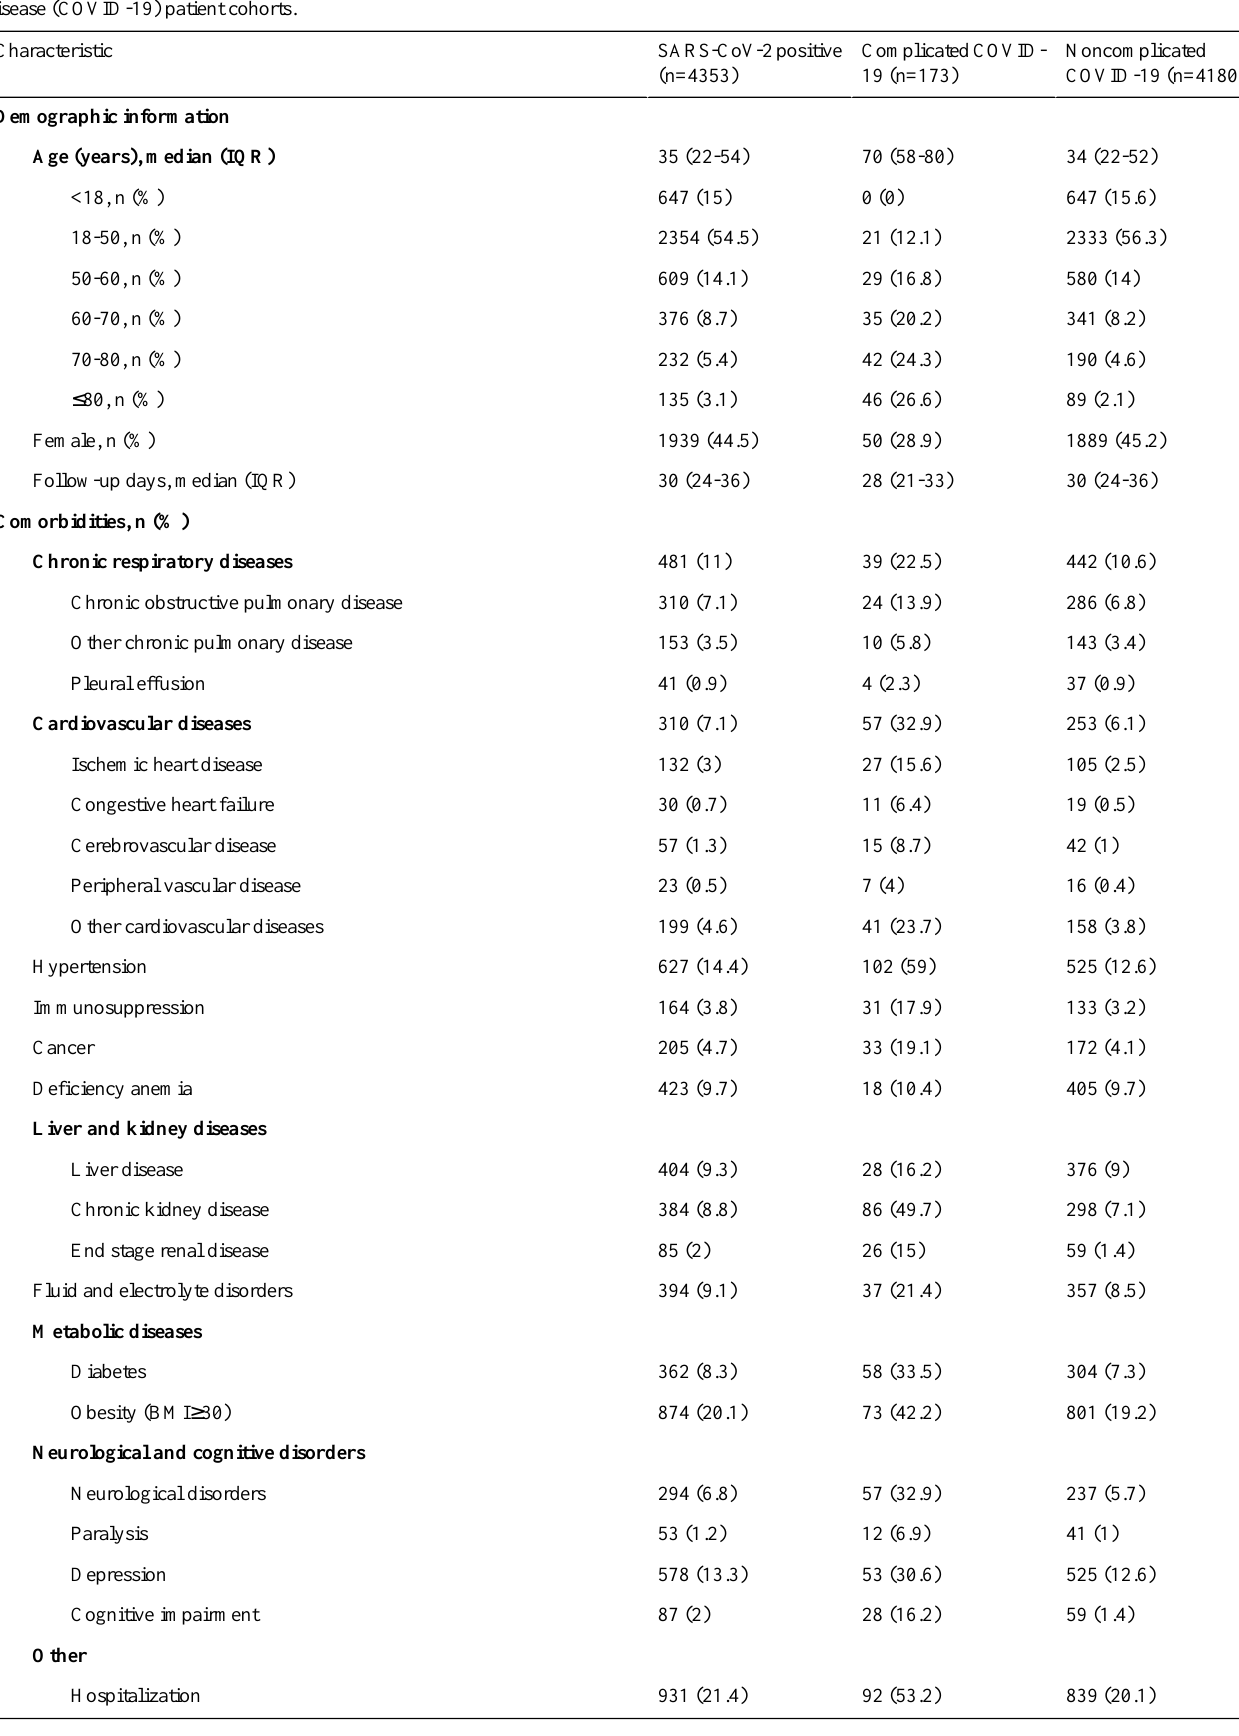
Table 1. Characteristics of the severe acute respiratory syndrome coronavirus 2 (SARS-CoV-2)–positive, complicated, and noncomplicated coronavirus disease (COVID-19) patient